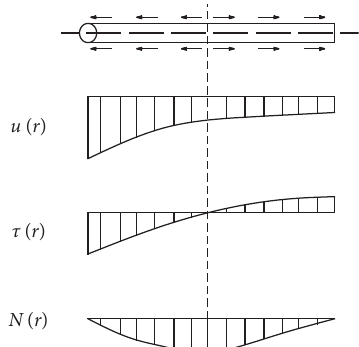
Figure 3: Distribution law of surrounding rock displacement and internal force of anchor bolt body.